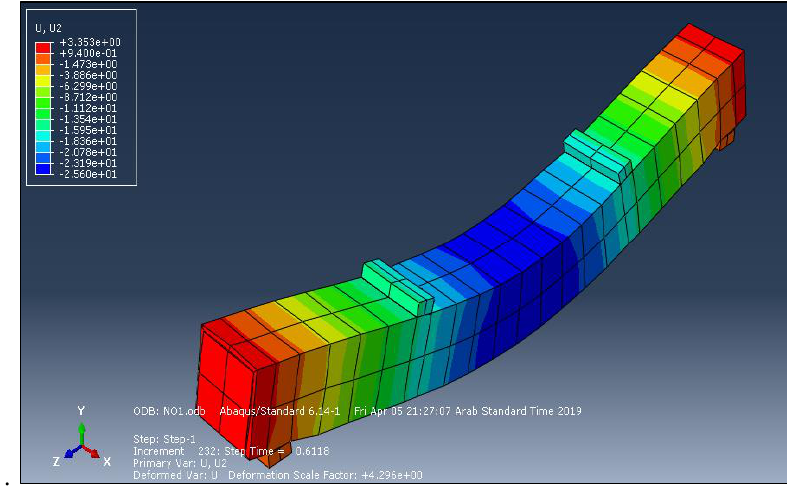
Fig. 6. Deflected shape of CFST